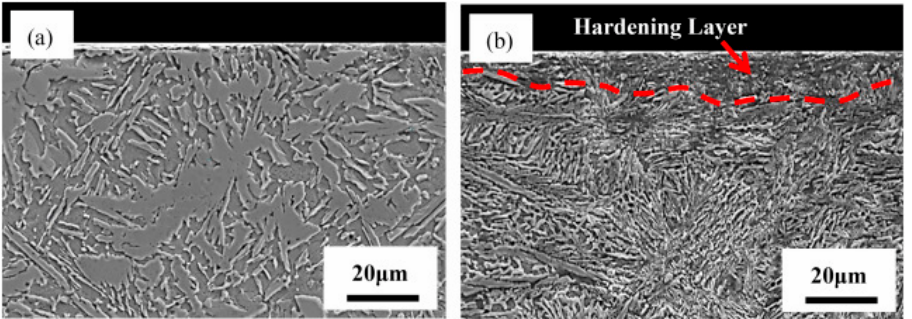
Figure 11. Cross-sectional morphologies of laser cladded AlCoCrCuFeNi HEA coatings: ( a ) without UIT; ( b ) with UIT. Reproduced with permission from [94]. Copyright Elsevier, 2021.